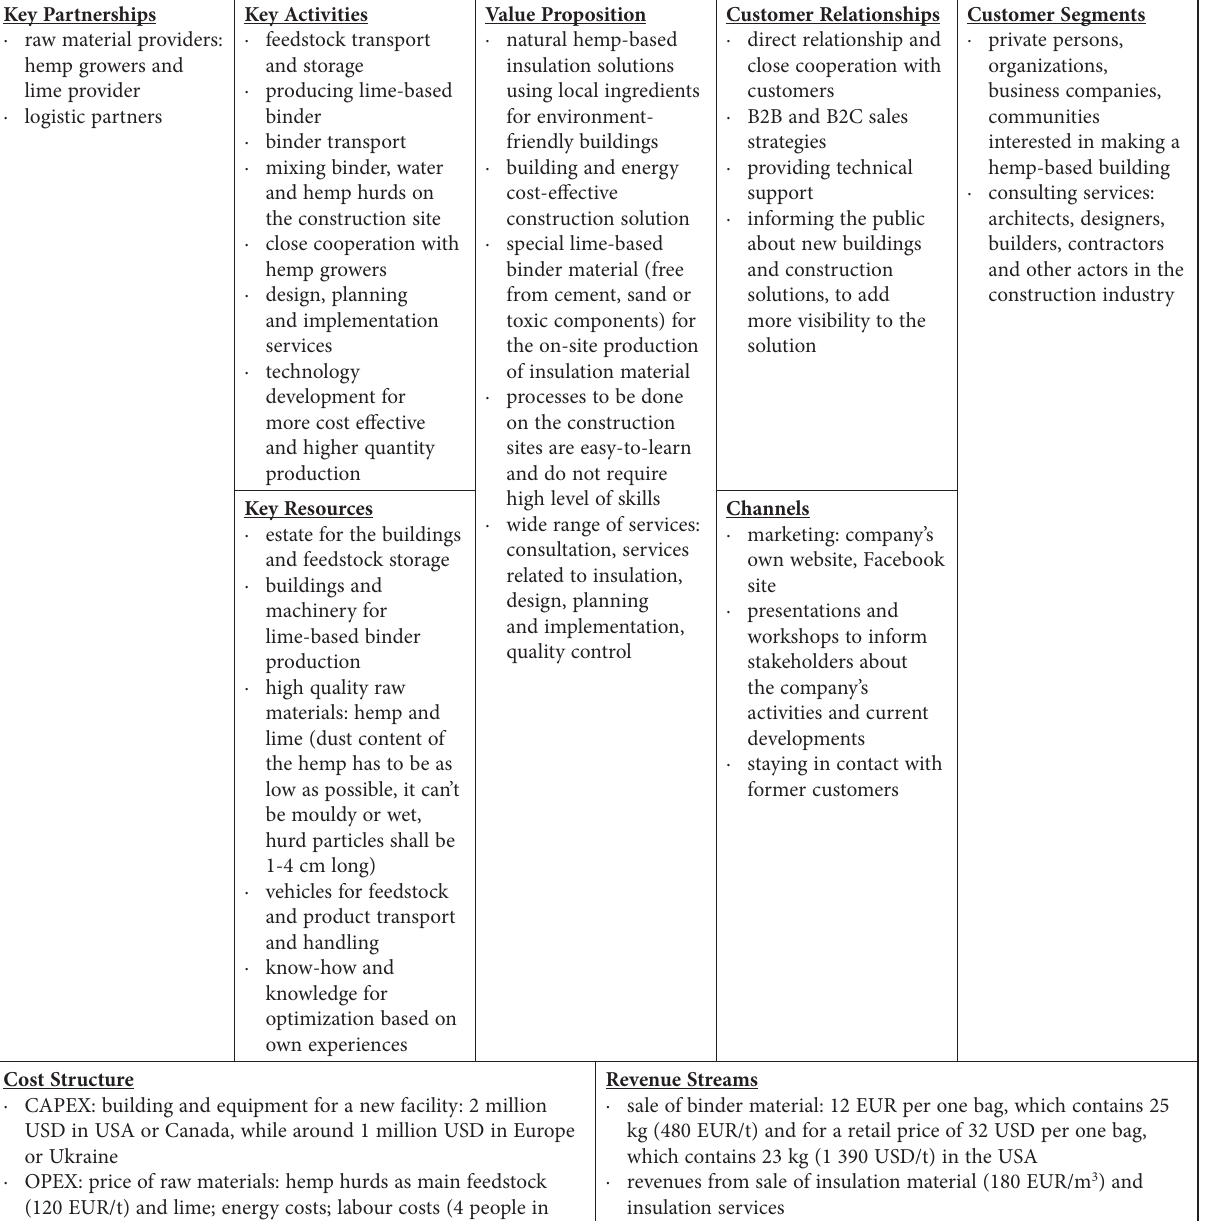
Figure 5. BMC of solution ‘S3’ (Hempire,